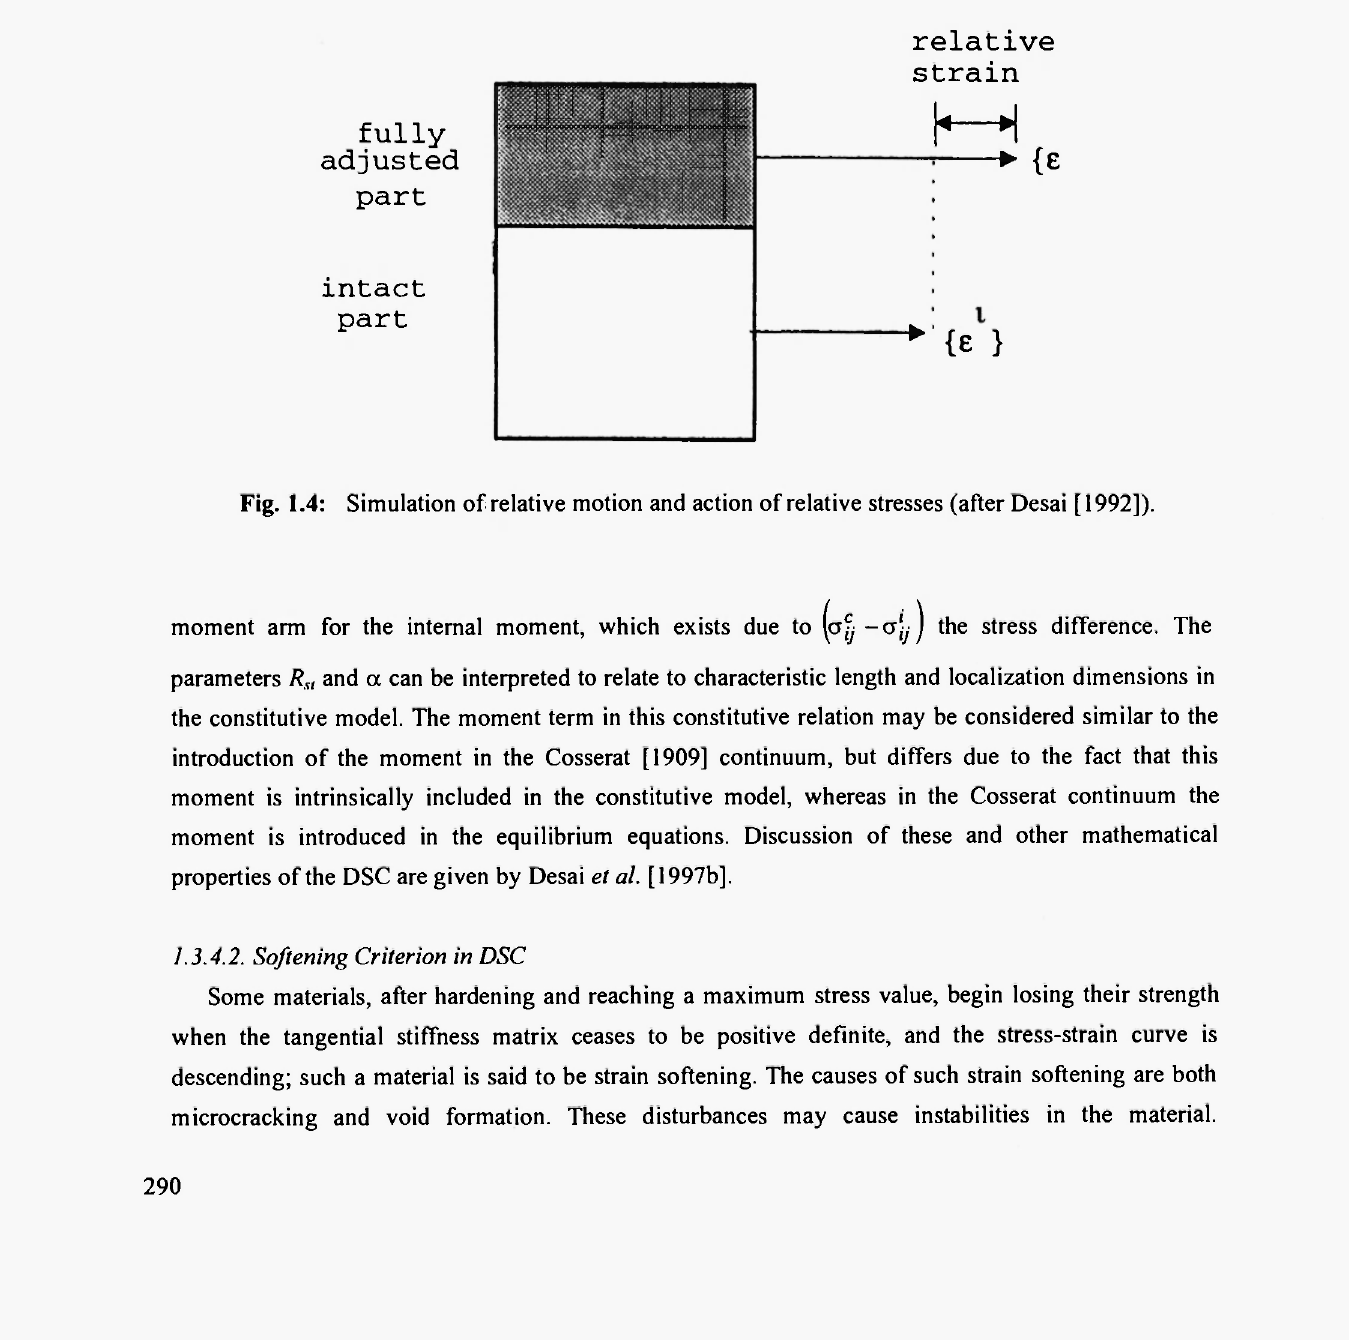
Fig. 1.4: Simulation of relative motion and action of relative stresses (after Desai [1992]).